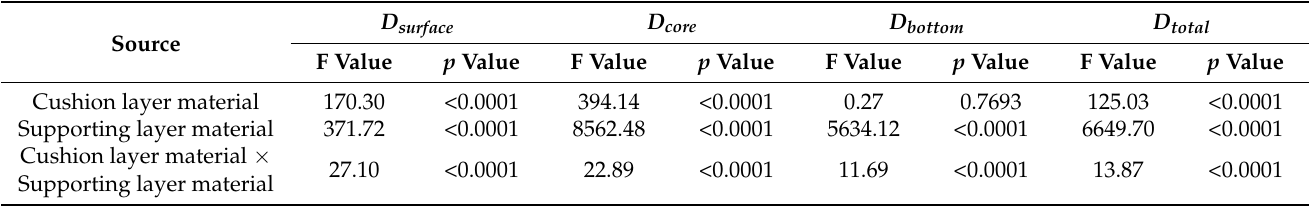
Table 2. The ANOVA results for the mattresses’